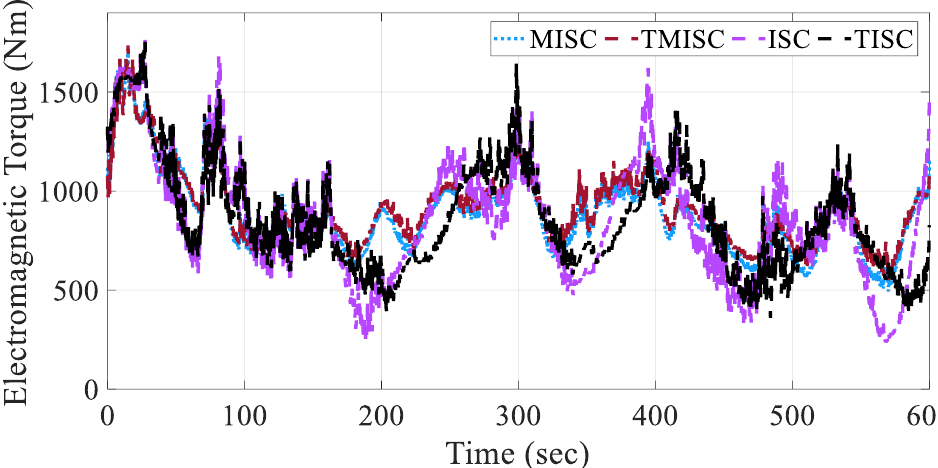
Figure 9. Comparison of generator torques for ISC, TISC, MISC and